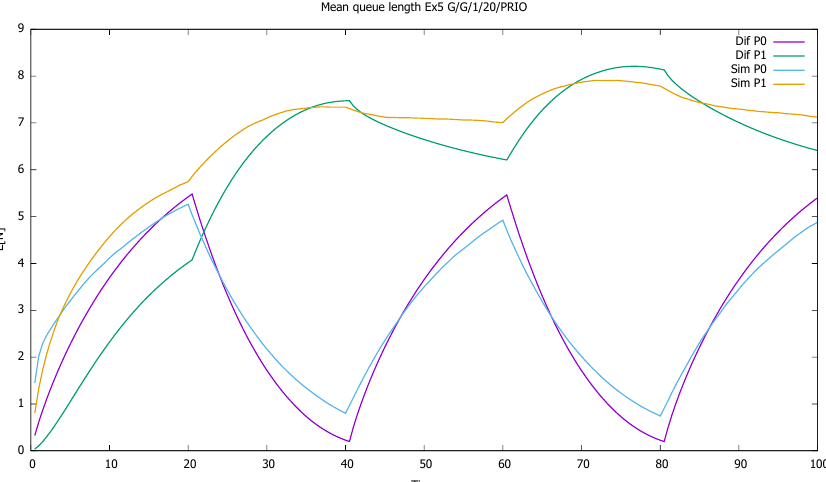
Figure 17. Section 3.5: mean queue lengths of priority (P0) and non-priority (P1) classes for very high values of C 2 , C 2 . B A